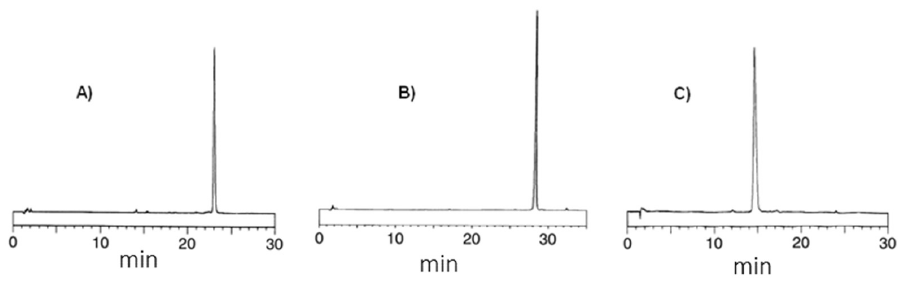
Figure 3. HPLC analysis of peptide–peptoid hybrids: 10 ( A ) (column: Zorbax SB-C18, 3.5 μm; 2.1 × 30 nm; gradient: from 50% to 100% acetonitrile in water within 15 min, 100% acetonitrile within 15 min; flow rate: 0.4 mL/min); 17 ( B ) (column: Lichrospher RP-8 (4 × 150 mm, 5μm); gradient: from 20% to 100% acetonitrile in water within 30 min; flow rate: 1 mL/min); 19 ( C ) (column: Lichrospher RP-8 (4 × 150 mm, 5μm); gradient: from 20% to 100% acetonitrile in water within 30 min; flow rate: 1 mL/min). All chromatograms were detected at 265 nm.